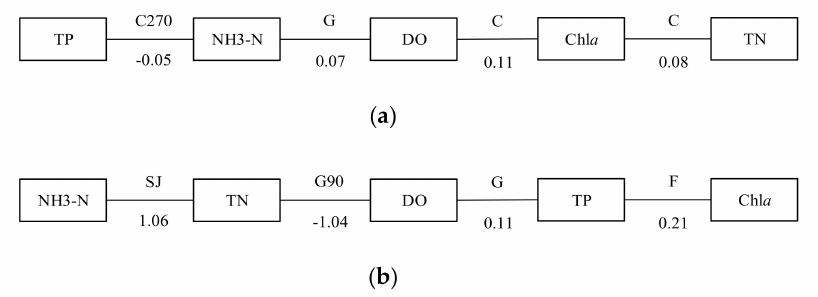
Figure 4. Structures of D-vine Tree 1, where C—Clayton copula, F—Frank copula, G—Gaussian copula, C90—rotated Clayton copula (90 degrees), G90—rotated Gumbel copula (90 degrees), C270—rotated